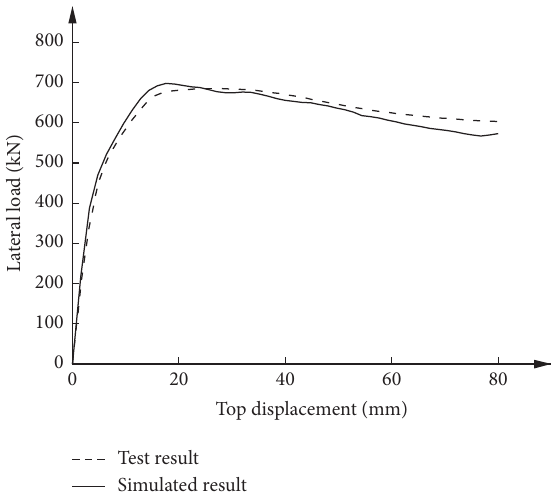
Figure 8: Verification of unbonded region’s constitutive relation.